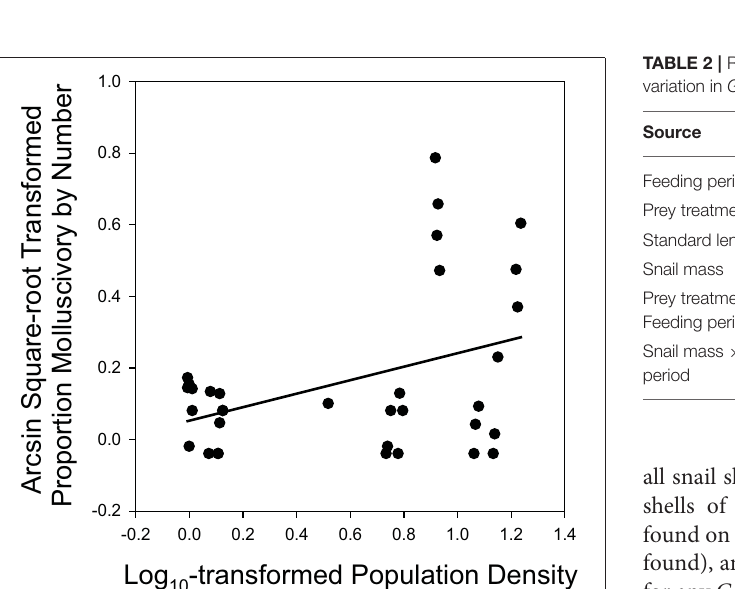
Log -transformed Population Density 10 FIGURE 5 | Increased proportion of molluscs in the diet in sites with higher conspecific densities based on stomach-content analyses of male, female, and juvenile Bahamian mosquitofish inhabiting tidal creeks on Abaco Island, The Bahamas (see Supplementary Table 4 ) based on our general linear model (see